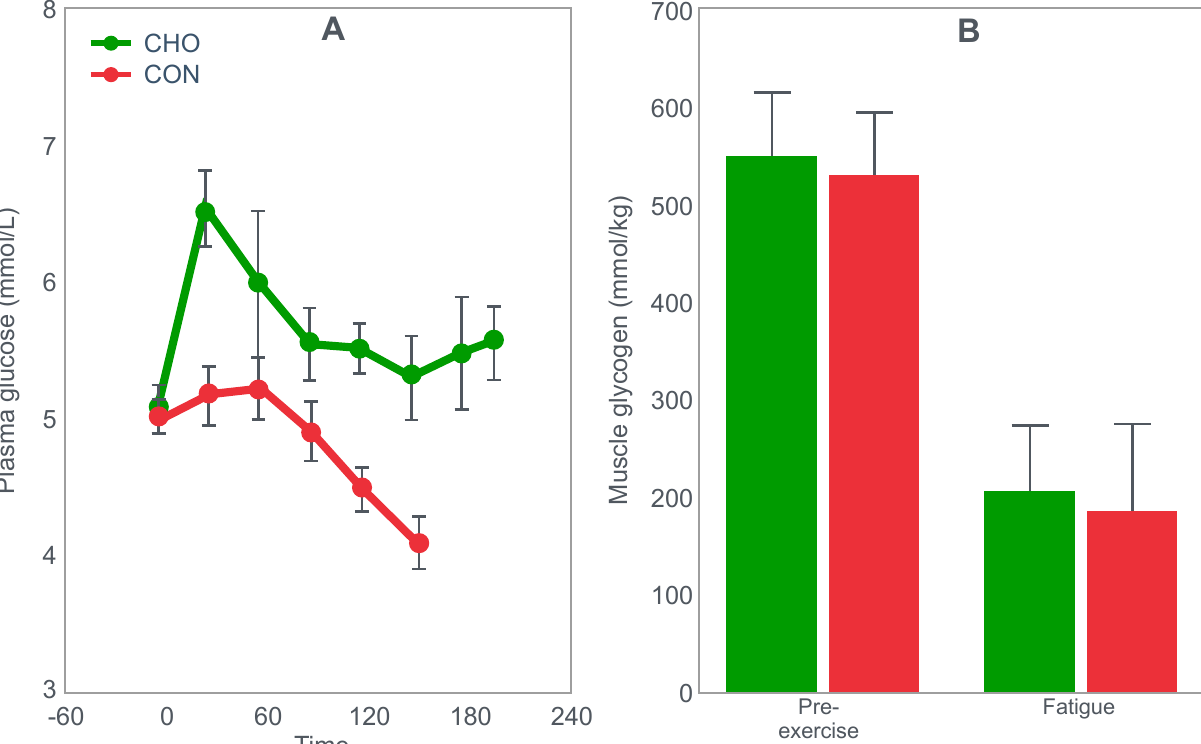
Figure 23. Changes in plasma glucose (panel A ) and muscle glycogen concentrations (panel B ) in subjects performing prolonged exercise with either carbohydrate (CHO) or placebo (CON) ingestion during exercise. Adapted with permission from ref. [57]. Copy-right 1999 American Physiological Society